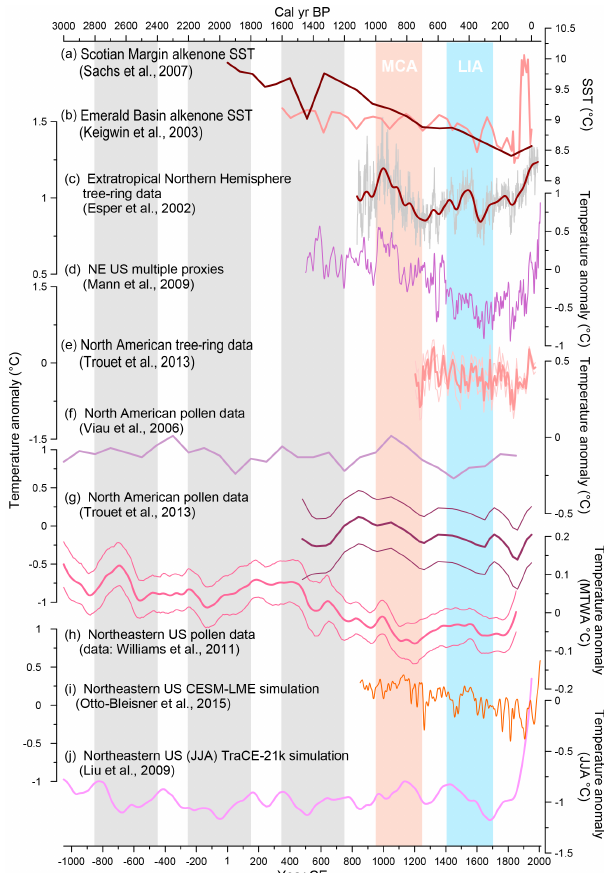
Figure 5. Temperature reconstructions for the last 3000 years for the NE US and adjacent regions, sourced from diverse paleoclimatic proxies and archives. (a) Sea surface temperature (SST) reconstruc- tions based on U K 37 in marine sediments (Sachs, 2007); (b) SST based on alkenone unsaturation in marine sediments (Keigwin et al., 2003); (c) tree-ring widths from the Northern Hemisphere extrat- ropics (Esper et al., 2002); (d) northeastern US grid cells areally averaged (from 37.5 to 47.5 ◦ N latitude and 67.5 to 77.5 ◦ W longi- tude) from multiple proxies (Mann et al., 2009); (e) tree-ring widths from temperate North America (Trouet et al., 2013); (f) North American pollen data (Viau et al., 2006); (g) North American pollen data (Trouet et al., 2013); (h) northeastern pollen data (Williams et al., 2011); (i) NE US (39 to 46 ◦ N latitude and 67.5 to 97.5 ◦ W longitude) temperature simulation from the Community Earth Sys- tem Model-Last Millennium Ensemble (Otto-Bliesner et al., 2015); (j) NE US temperature simulation from the Community Climate System Model version 3 SynTrace experiment (TraCE-21k; Liu et al., 2009). Vertical gray bands are only provided as a visual aid to identify the timing of features in the records. Pink and blue vertical bars mark the MCA and LIA